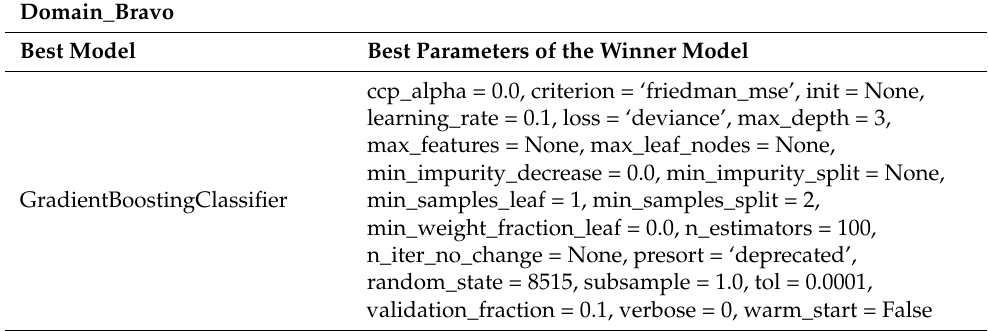
Table 4. Best parameters of the winner model of the Domain Bravo.